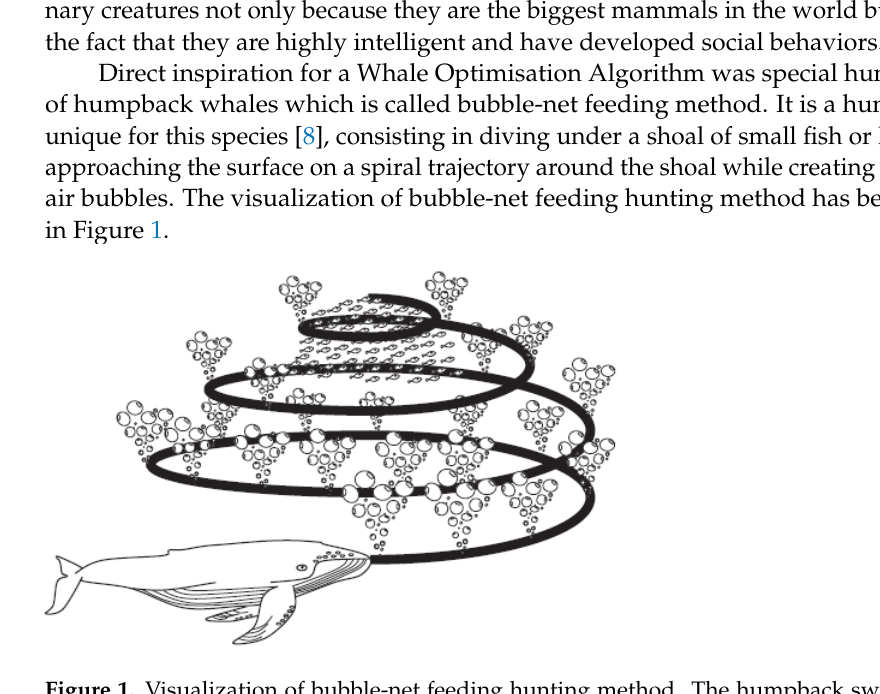
Figure 1. Visualization of bubble-net feeding hunting method. The humpback swims in a spiral below the prey, creating bubbles that trap them [8]. Reproduced with permission from Elsevier publisher, licence no.